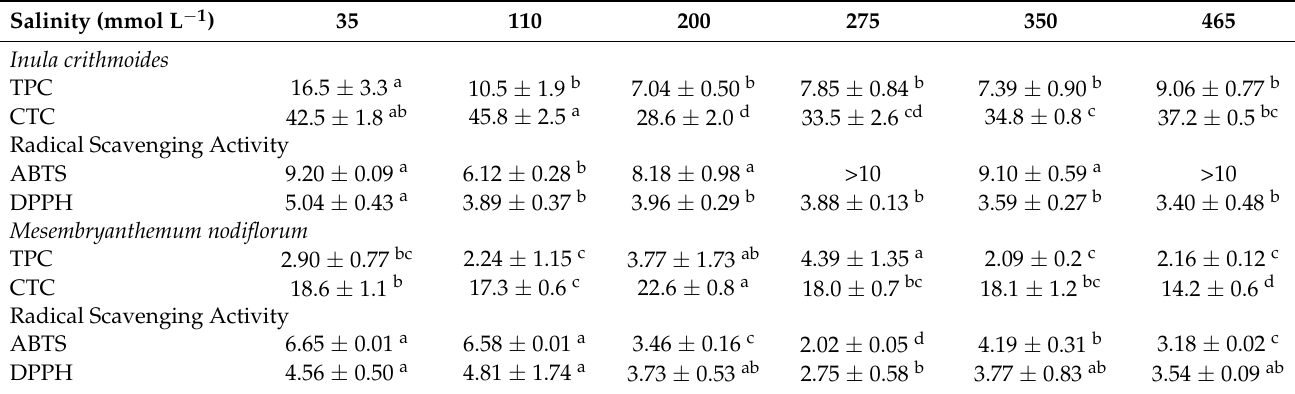
Table 3. Total phenolics contents (TPC; mg GAE g − 1 dw), condensed tannin content (CTC; mg CE g − 1 dw), and antioxidant activity-radical scavenging (IC 50 mg mL − 1 of extract) of I. crithmoides and M. nodiflorum cultivated at six different salinities. Salinity (mmol L − 1